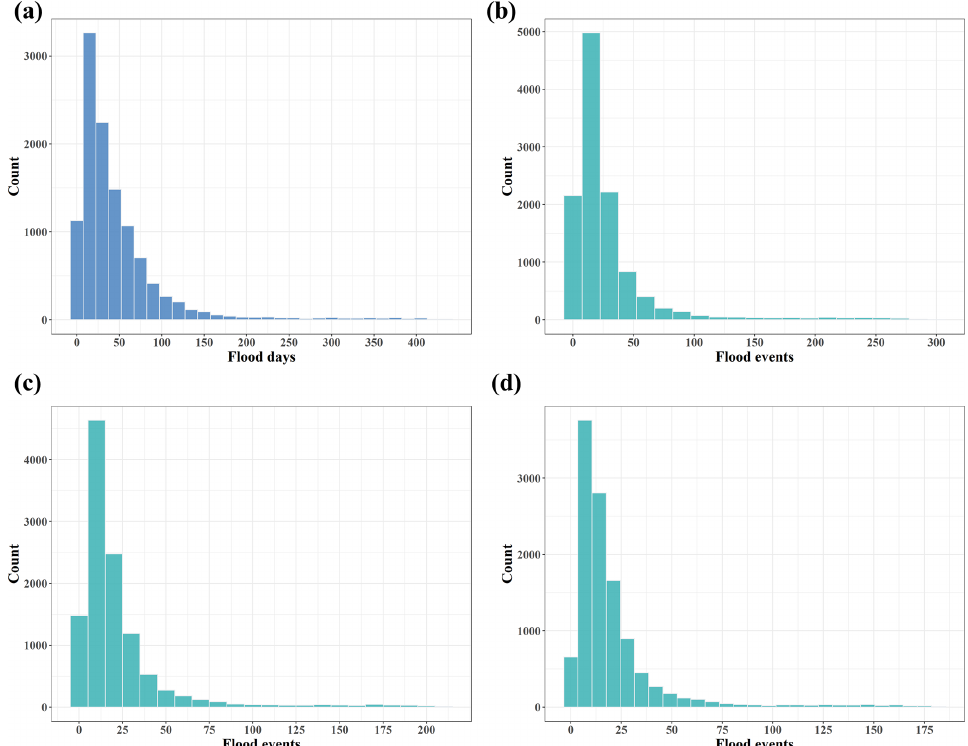
Figure 3. Histograms of cumulative flood days and flood events from 1 April 2002 to 31 August 2016: (a) histogram of global flood days from 1 April 2002 to 31 August 2016; (b) histogram of global flood events based on consecutive detected flood days; (c) histogram of global flood events based on the interval between 2 consecutive flood days not exceeding 3d; (d) histogram of global flood events based on the interval between 2 consecutive flood days not exceeding 5d.